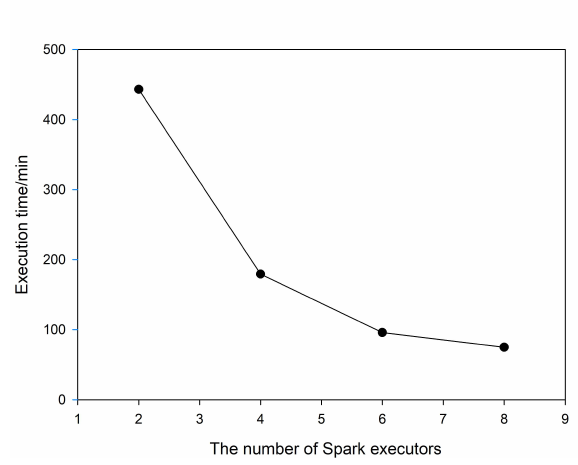
Figure 18. Comparison of the execution times of different numbers of executors. Table 6. Time comparison of different numbers of executors (time unit: